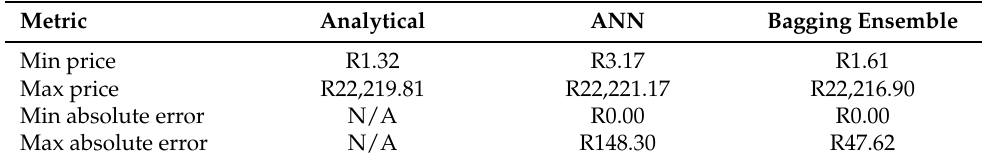
Table 5. Magnitude of errors: zero collateral.